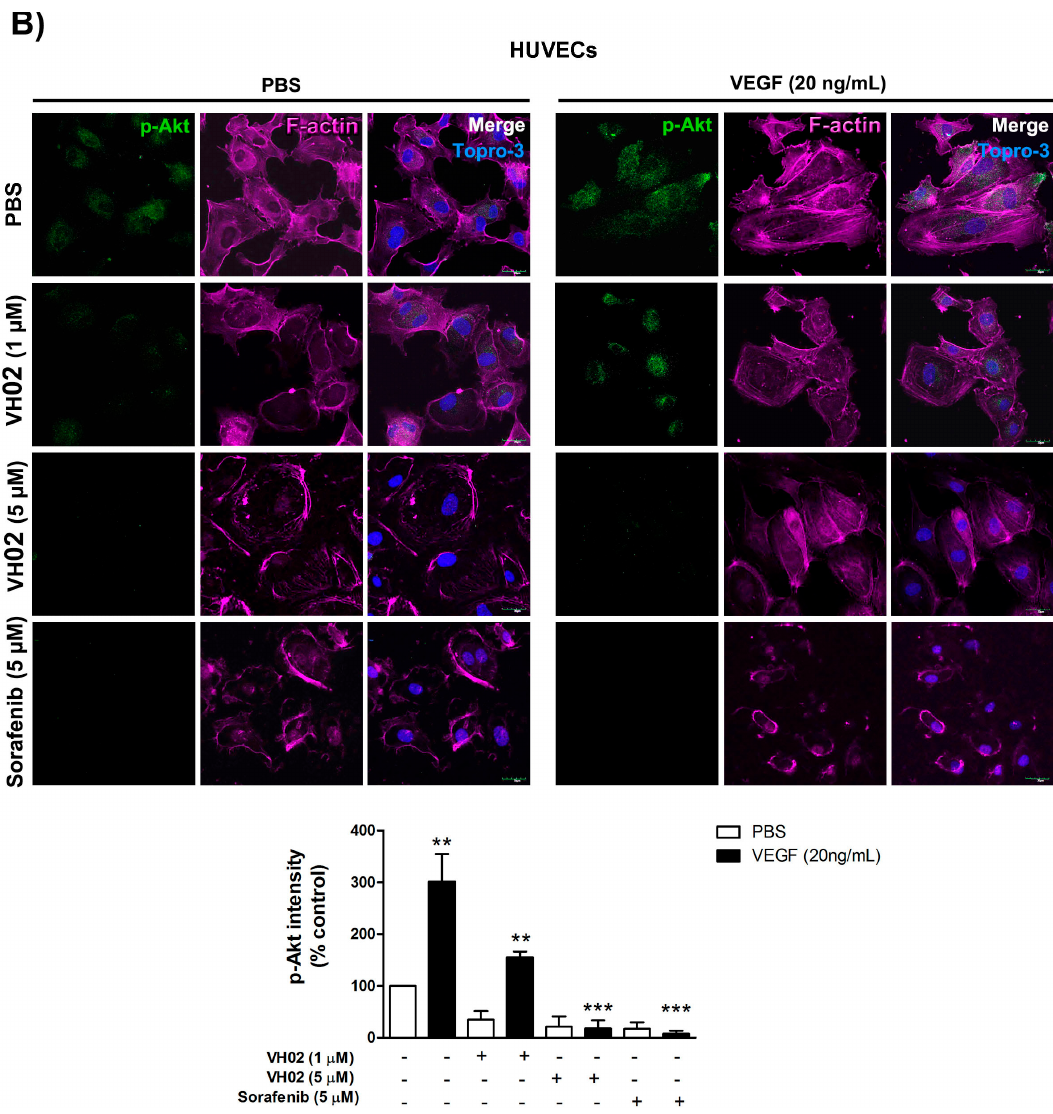
Figure 6. Effects of VH02 on VEGFR2 and Akt phosphorylation, and actin polymerization in HUVECs in normal control group (PBS) and VEGF-induced condition. ( A ) Representative confocal immunofluorescence images of HUVECs stained by fluorescent-tagged anti-p-VEGFR2 Tyr1175 antibody (green) in the presence and absence of VEGF treatment (control); ( B ) Representative confocal immunofluorescence images of HUVECs stained with fluorescent-tagged anti-p-Akt Ser473 antibody (green) in the presence and absence of VEGF treatment (control). HUVECs were pretreated for 30 min with VH02 or sorafenib as indicated in the figure. The slides were also counter-stained with antibodies against F-actin (pink). Cell nuclei were identified by Topro-3 (blue). All images were taken at the same exposure time by confocal microscopy with Z-stack projections (600× magnification). Scale bars, 30 μ m. Fluorescence intensity values were represented as mean ± SEM of duplicate separate experiments with five randomly images from each group. ** p < 0.01, *** p <0.001 compared with PBS of each pair of treatment (analyzed by two-way ANOVA).